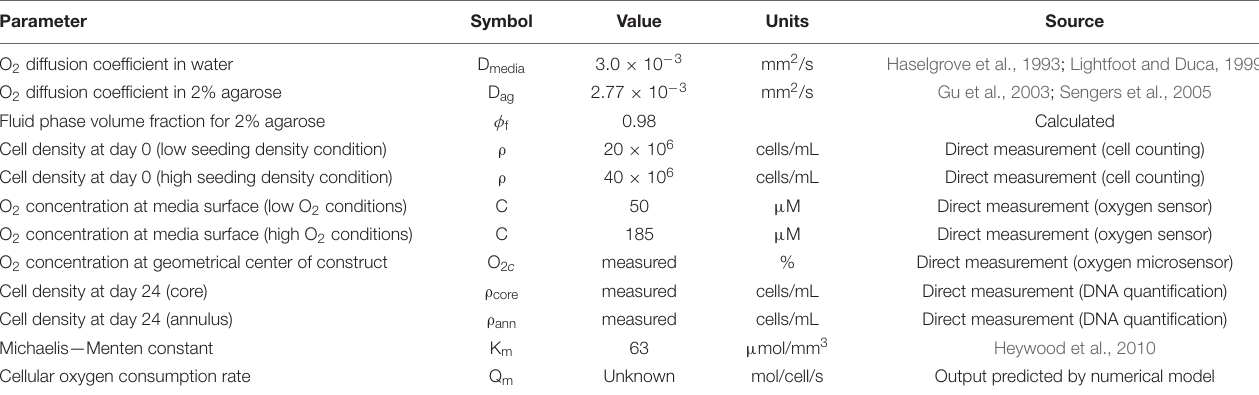
TABLE 1 | Summary of parameters used for oxygen diffusion-reaction